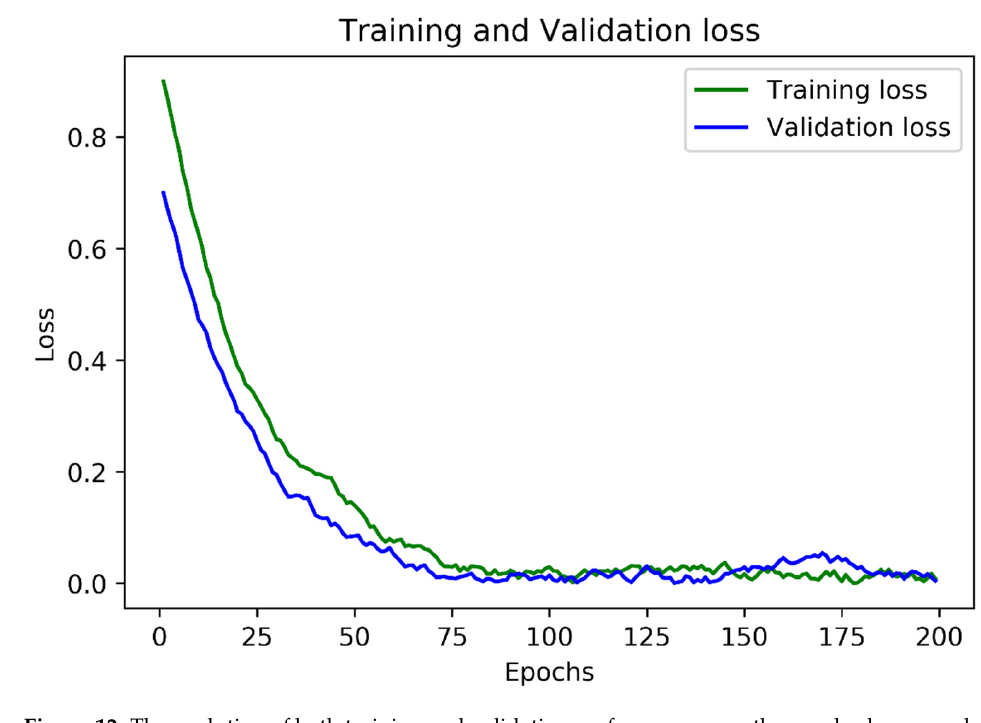
Figure 12. The evolution of both training and validation performance over the epochs; here, we show the first 200 epochs.